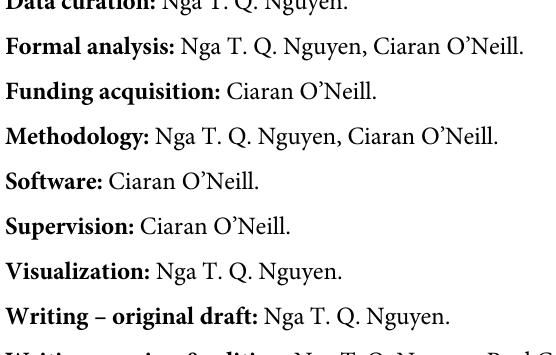
S1 Fig. The marginal effects on HRQoL from Model 2. S2 Fig. The marginal effects on HRQoL from Model 3. S3 Fig. Projected economic burden of CKD up to 2025 in the UK by stage and gender. S1 Table. Sensitivity analysis